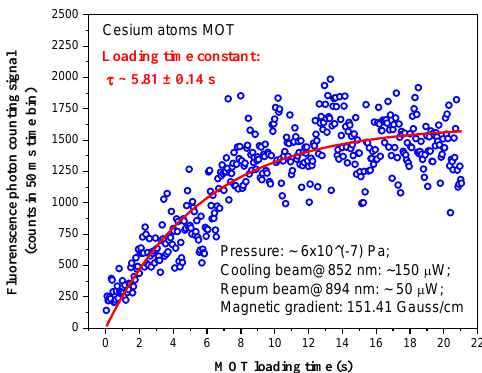
Figure 1. Loading curve of the magneto-optical trap (MOT). The MOT is empty when the quadrupole magnetic field is turned off. After the quadrupole magnetic field is turned on, atoms are gradually loaded into the MOT. The typical time constant of the MOT is 5.81 ± 0.14 s, and the corresponding pressure in the Cs vapor cell is approximately 6 × 10 −7 Pa.